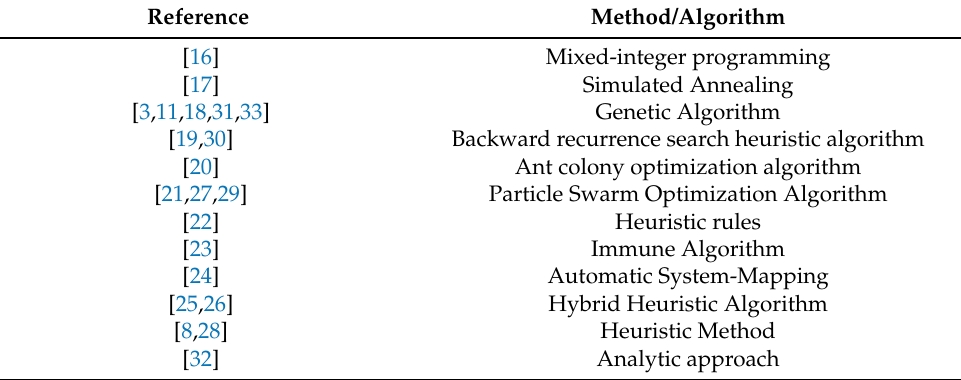
Table 1. Summary of the algorithms presented in the state of the art.